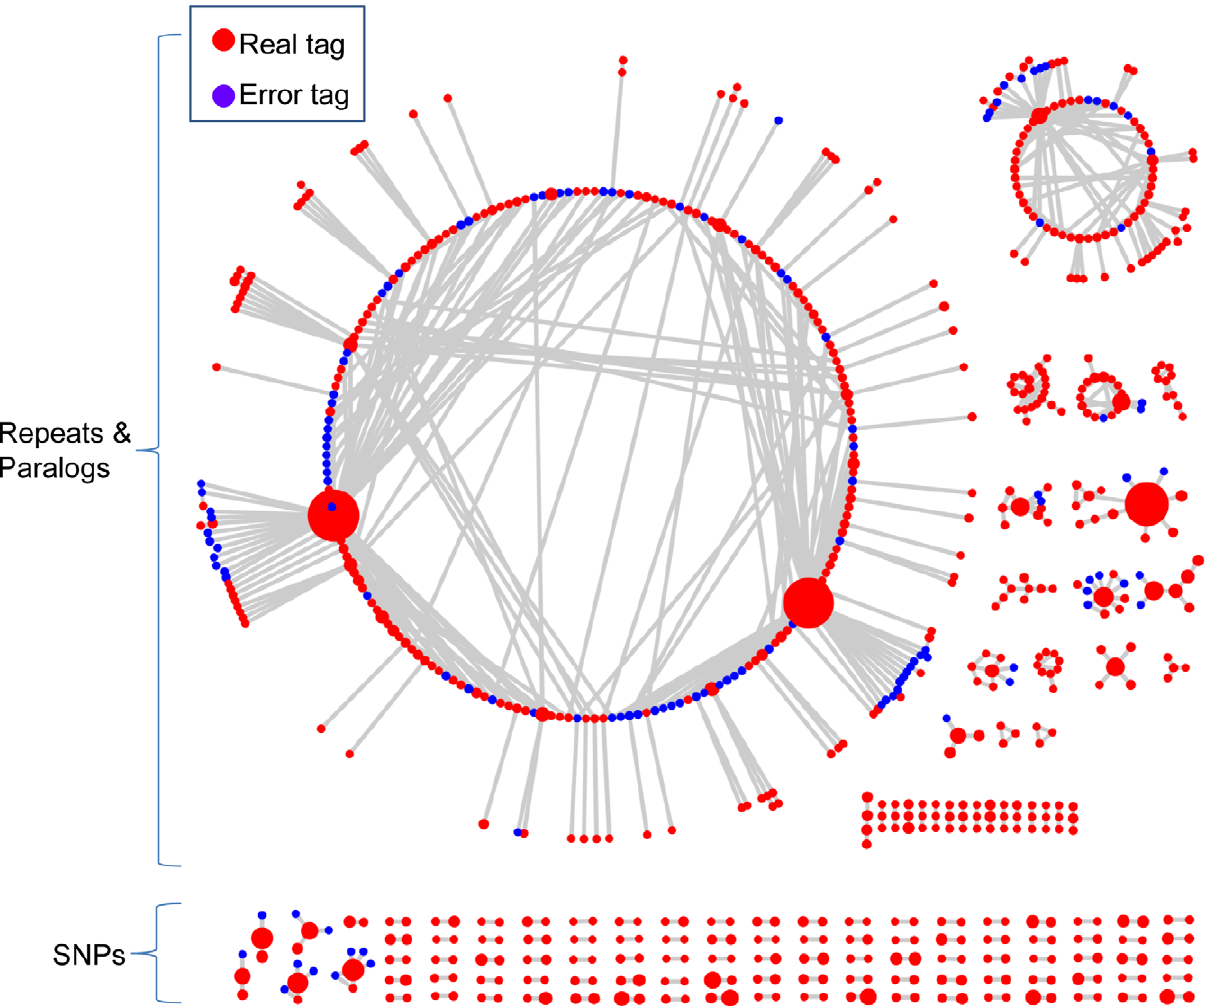
Figure 2. The networks of 802 representative tags from actual switchgrass data. The red circles are putative ‘‘real’’ tags. The blue circles are low frequency, putative error tags (see Methods). The size of each circle denotes the count of a tag. Lines connecting the circles (‘‘edges’’) join tags that differ by a single bp mismatch. Of the 802 tags, 192 (24%) formed reciprocal tag pairs and thus, were identified as SNPs by the network filter.